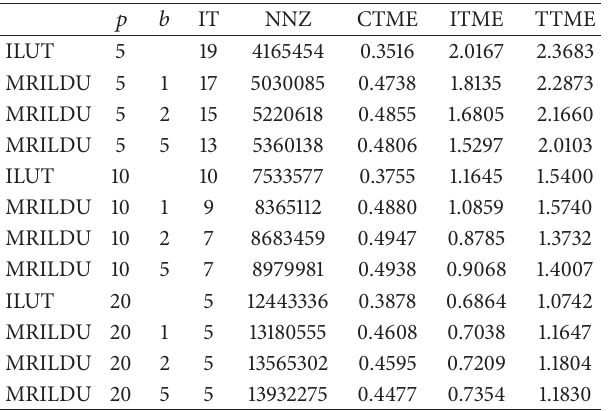
Table 4: Iteration results for matrix ldoor.